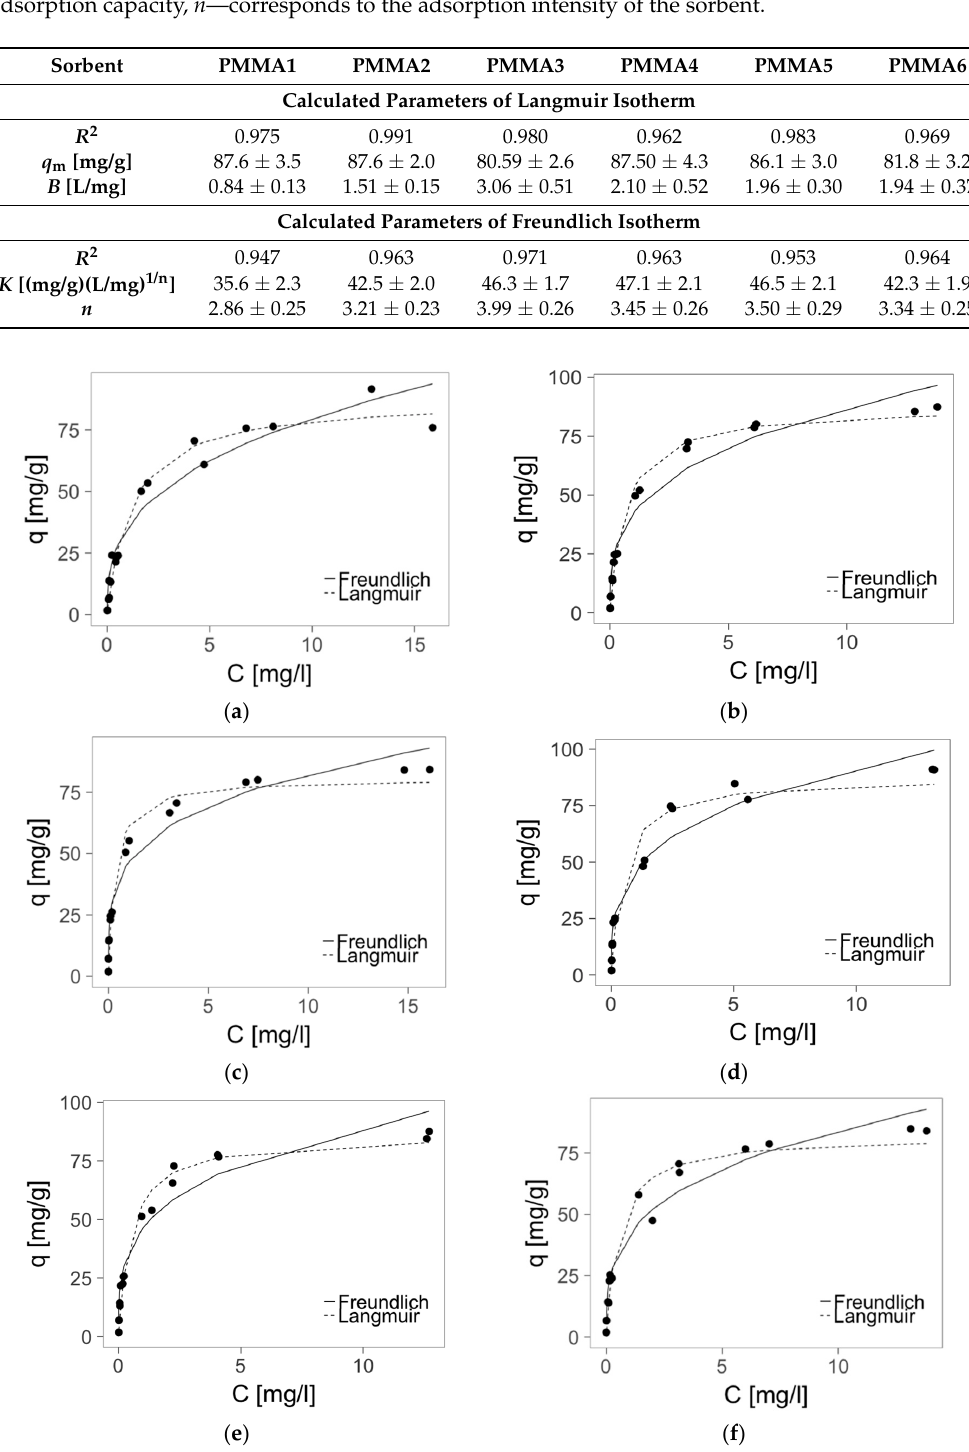
Figure 6. Adsorption isotherms of zinc on PMMA-based sorbents: ( a ) PMMA1; ( b ) PMMA2; ( c ) PMMA3; ( d ) PMMA4; ( e ) PMMA5; ( f ) PMMA6. Mass of sorbent 0.01 g, volume of solution: 0.025 L, pH = 6, temperature 22 ± 1 °C, time of contact 24 h.